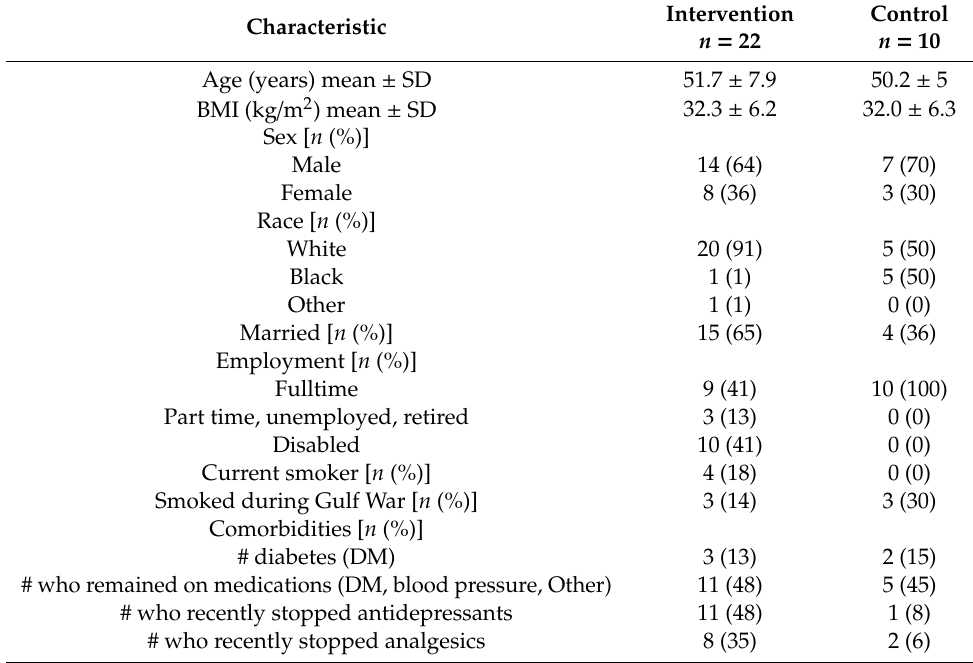
Table 1. Baseline and health characteristics of the study